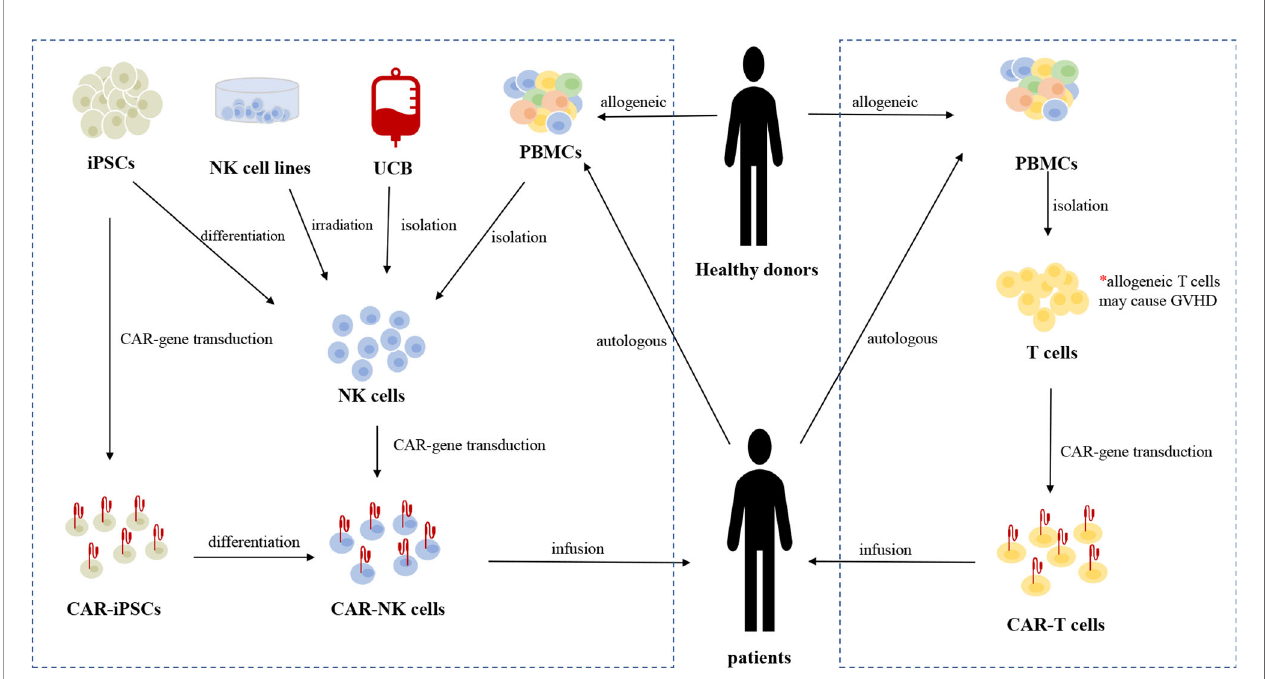
FIGURE 2 | The sources and manufacturing process of CAR-NK cells and CAR-T cells, respectively. Current sources of clinical-grade NK cells include the NK92 cell line, autologous or allogeneic PBMC-derived NK cells, UCB-derived NK cells, and iPSCs-derived NK cells. iPSCs can be genetically engineered with CAR-gene and the resulting CAR-iPSCs can be differentiated into homogeneous CAR-NK cells for clinical use. Irradiation is necessary before the infusion of CAR-NK92 cells to eliminate the potential risk of malignant transformation. At present, autologous PBMC-derived T cells are the main source of T cells for CAR-gene engineering. Allogeneic T cells from healthy donors may cause life-threatening GVHD due to HLA